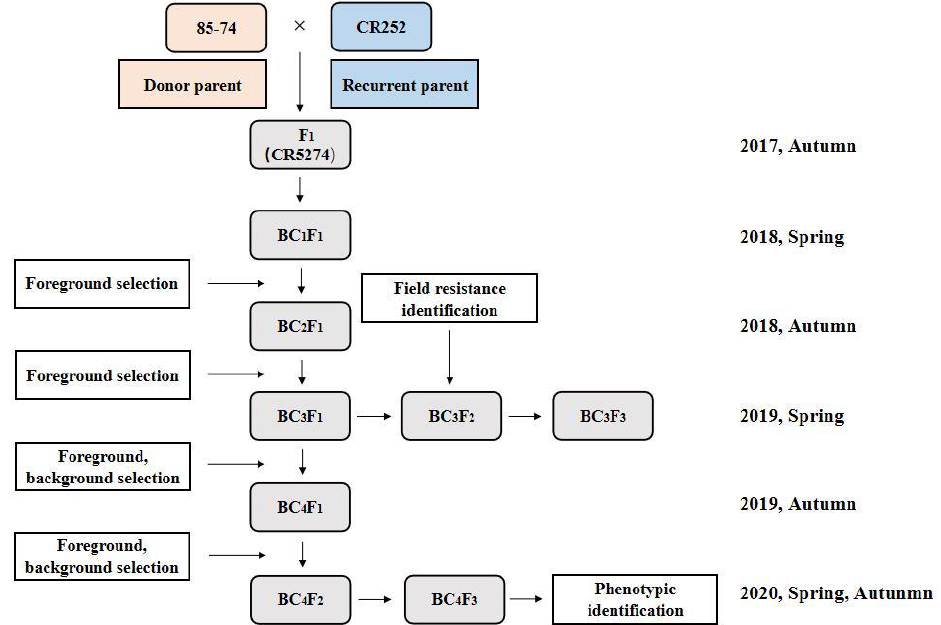
Figure 1. Schematic diagram of marker-assisted gene pyramiding. CR252: recurrent parent; 85-74: donor parent.